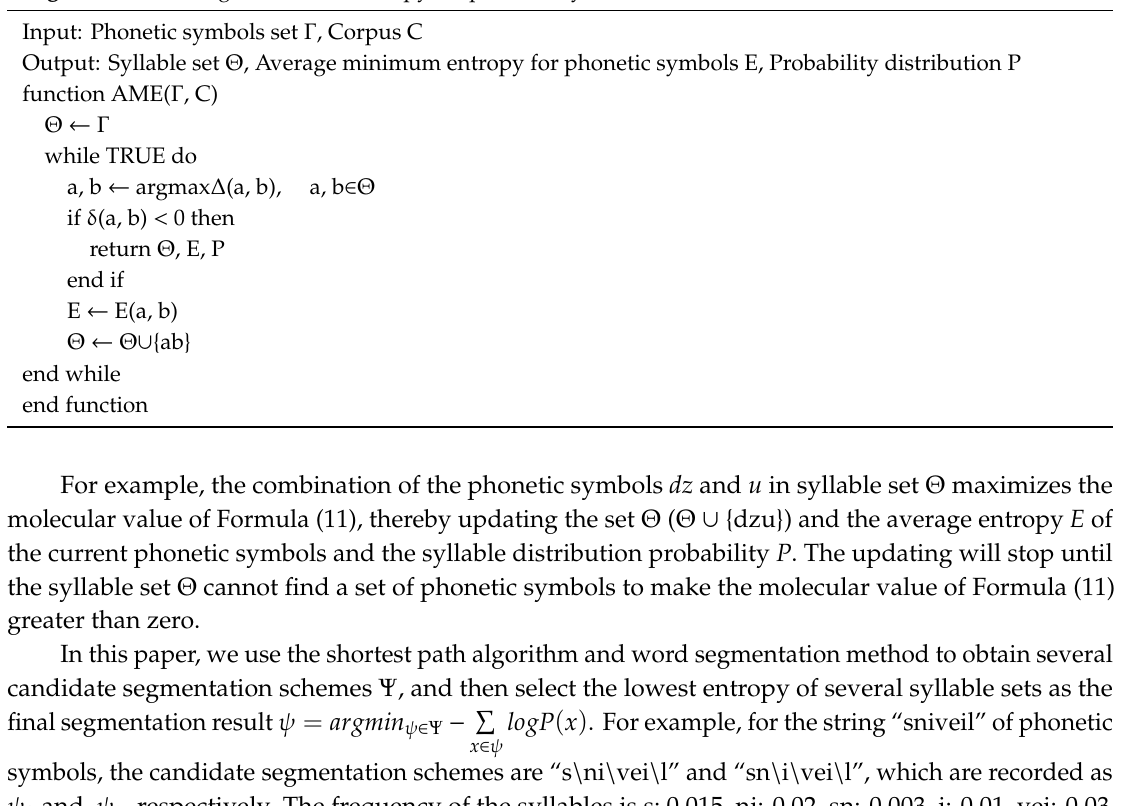
Algorithm 2 : Average minimum entropy for phonetic